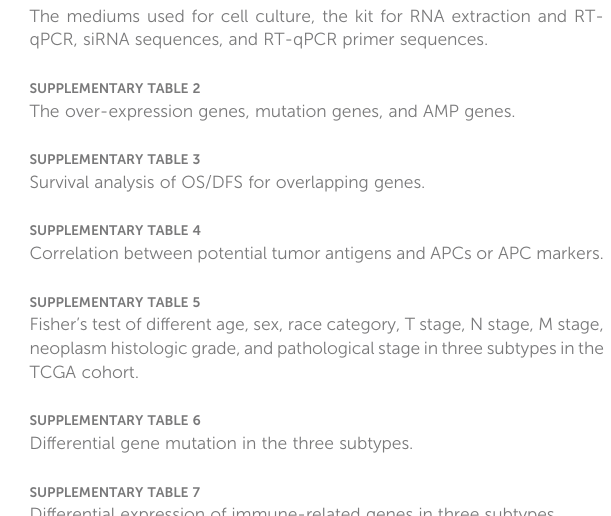
SUPPLEMENTARY TABLE 6 Differential gene mutation in the three subtypes. SUPPLEMENTARY TABLE 7 Differential expression of immune-related genes in three subtypes. SUPPLEMENTARY TABLE 8 Metascape analysis of differential immune-related